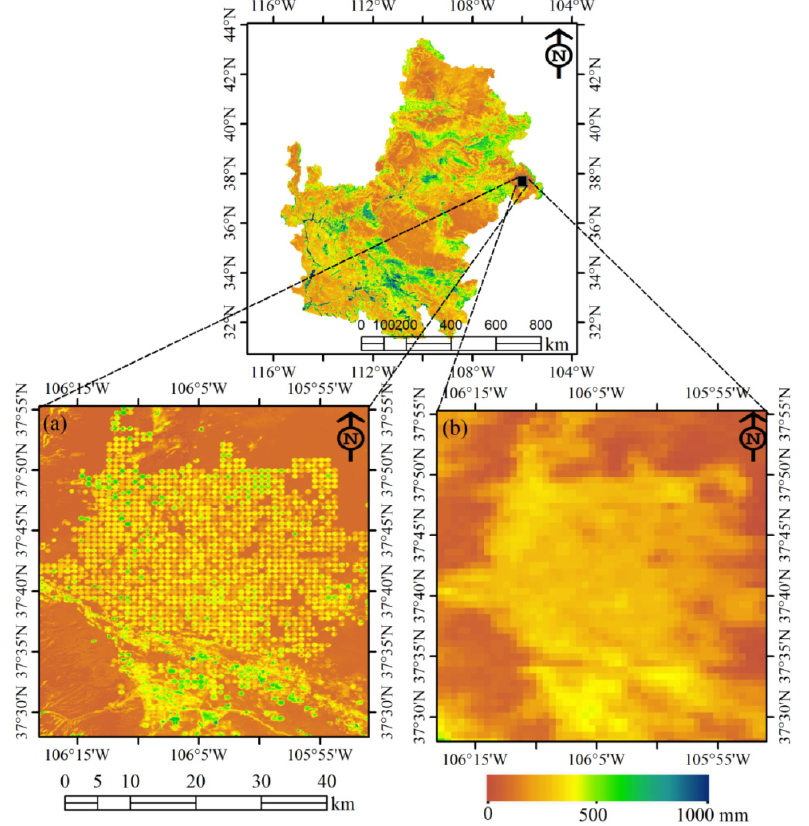
Figure 11. Example showing the spatial distribution of annual evapotranspiration map of the same area within the Colorado River Basin with ( a ) zoomed in view of the Landsat-based evapotranspiration map for the area in the black square; and ( b ) zoomed in view of the MODIS-based evapotranspiration map in the black square area. Legend and scale shown at the bottom are for images Figure